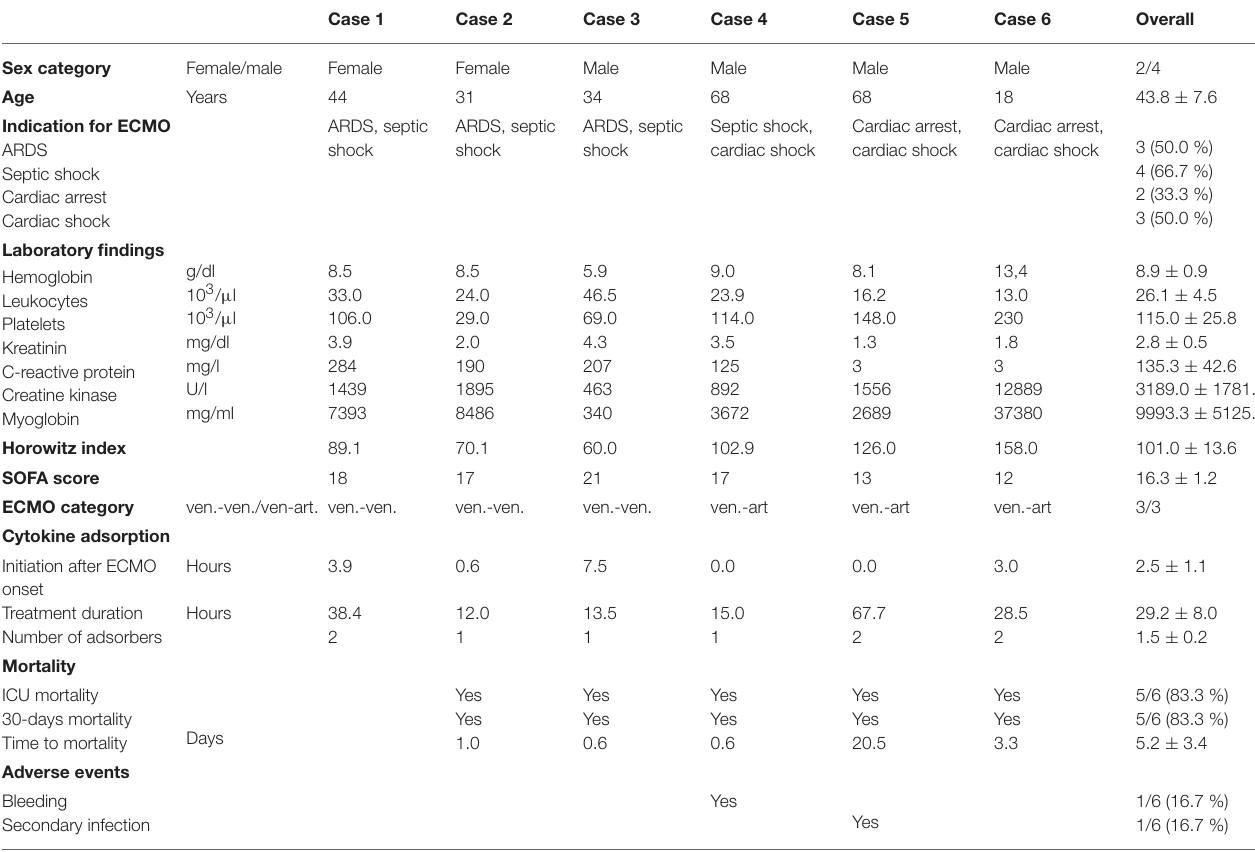
TABLE 1 | Patient characteristics, laboratory findings and outcome.